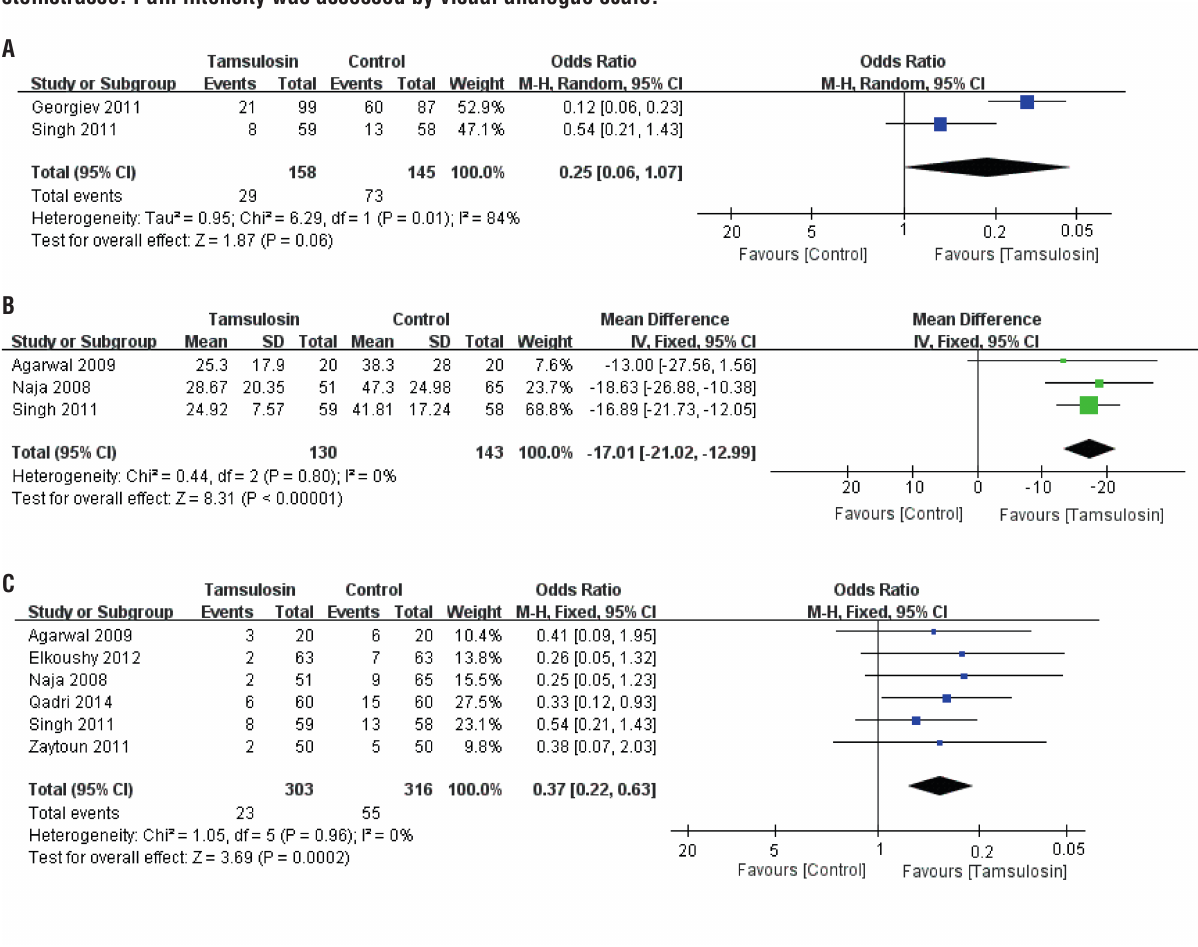
Figure 5 - Forest plots with complications as the outcome for: A) incidences of colic; B) pain intensity; C) incidence of steinstrasse. Pain intensity was assessed by visual analogue